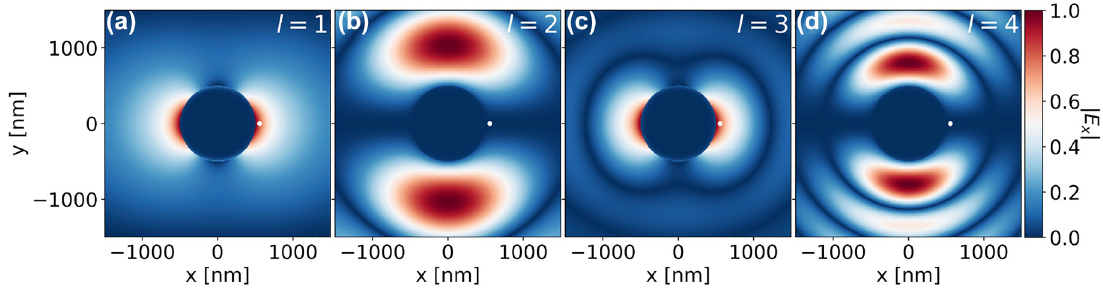
| fields of a 1 μ m NP excited by an x -polarised plane wave, obtained from the multipolar decomposition for modes (a) l = 1, Figure 3: Total | E x